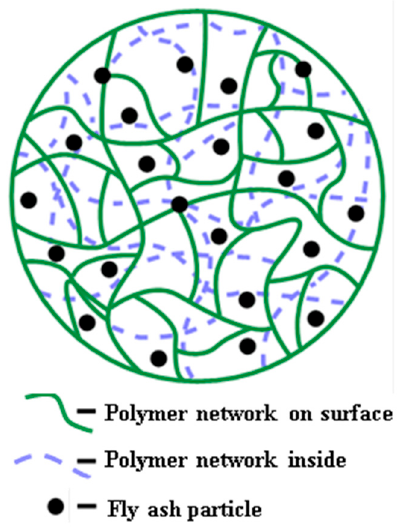
Figure 6. Proposed three dimensional structure of PAA-AM/FA superabsorbent composite.